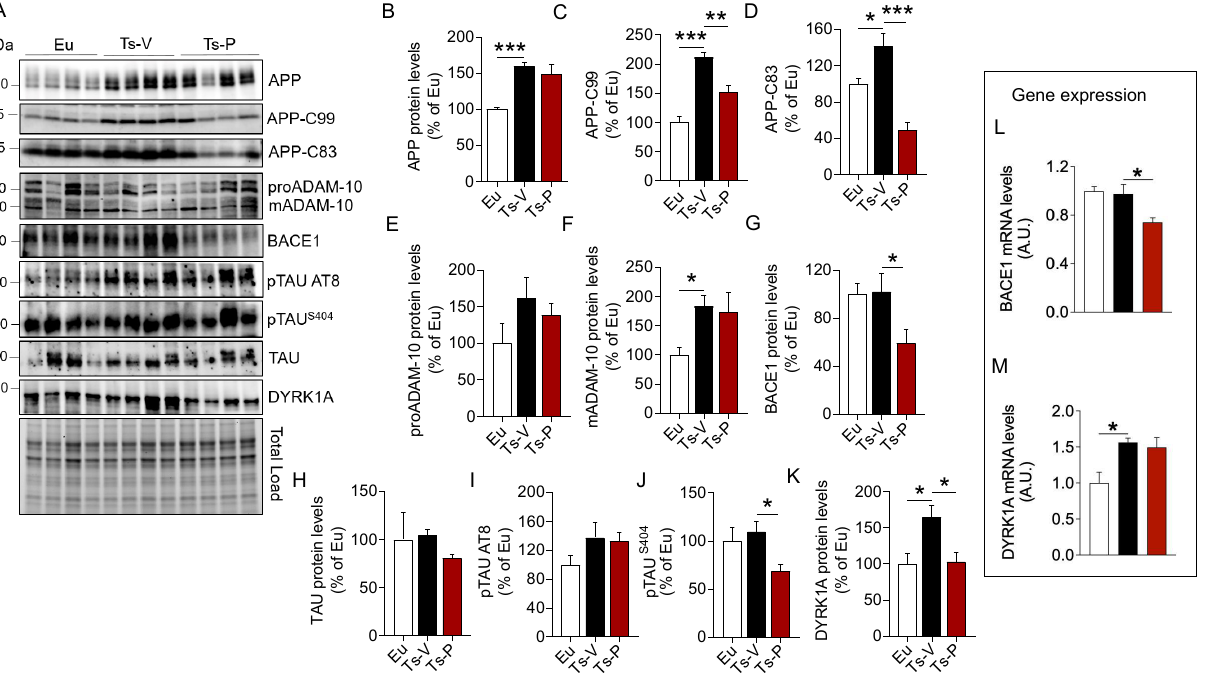
Figure 2. Reduced AD neuropathological hallmarks following KYCCSRK intranasal administration in Ts2Cje mice. APP, APP-CTFs, BACE1, TAU and DYRK1A protein levels and phosphorylation were evaluated in the frontal cortex of Eu and Ts2Cje (Ts-V) mice treated with vehicle (saline) and Ts2Cje (Ts-P) treated with KYCCSRK peptide (0.5 mM) for two weeks (n = 4/group). ( A ) Representa- tive Western blot and total load images and densitometric evaluation of ( B – D ) APP, -C83 and -C99 fragments protein levels, ( E-F ) immature (proADAM-10) and mature (mADAM-10) forms of ADAM-10 protein levels, (G) BACE1 protein levels, ( H – J ) TAU protein levels, AT8 and S404 phos- phorylation, and ( K ) DYRK1A protein levels. All densitometric values were normalized per total protein load and are given as a percentage of Eu set as 100%. In ( L , M ) BACE1 and DYRK1A mRNA levels are shown. Data are shown as mean ± SEM. One-way ANOVA with Dunnett test: * p < 0.05, ** p < 0.01, *** p < 0.001.